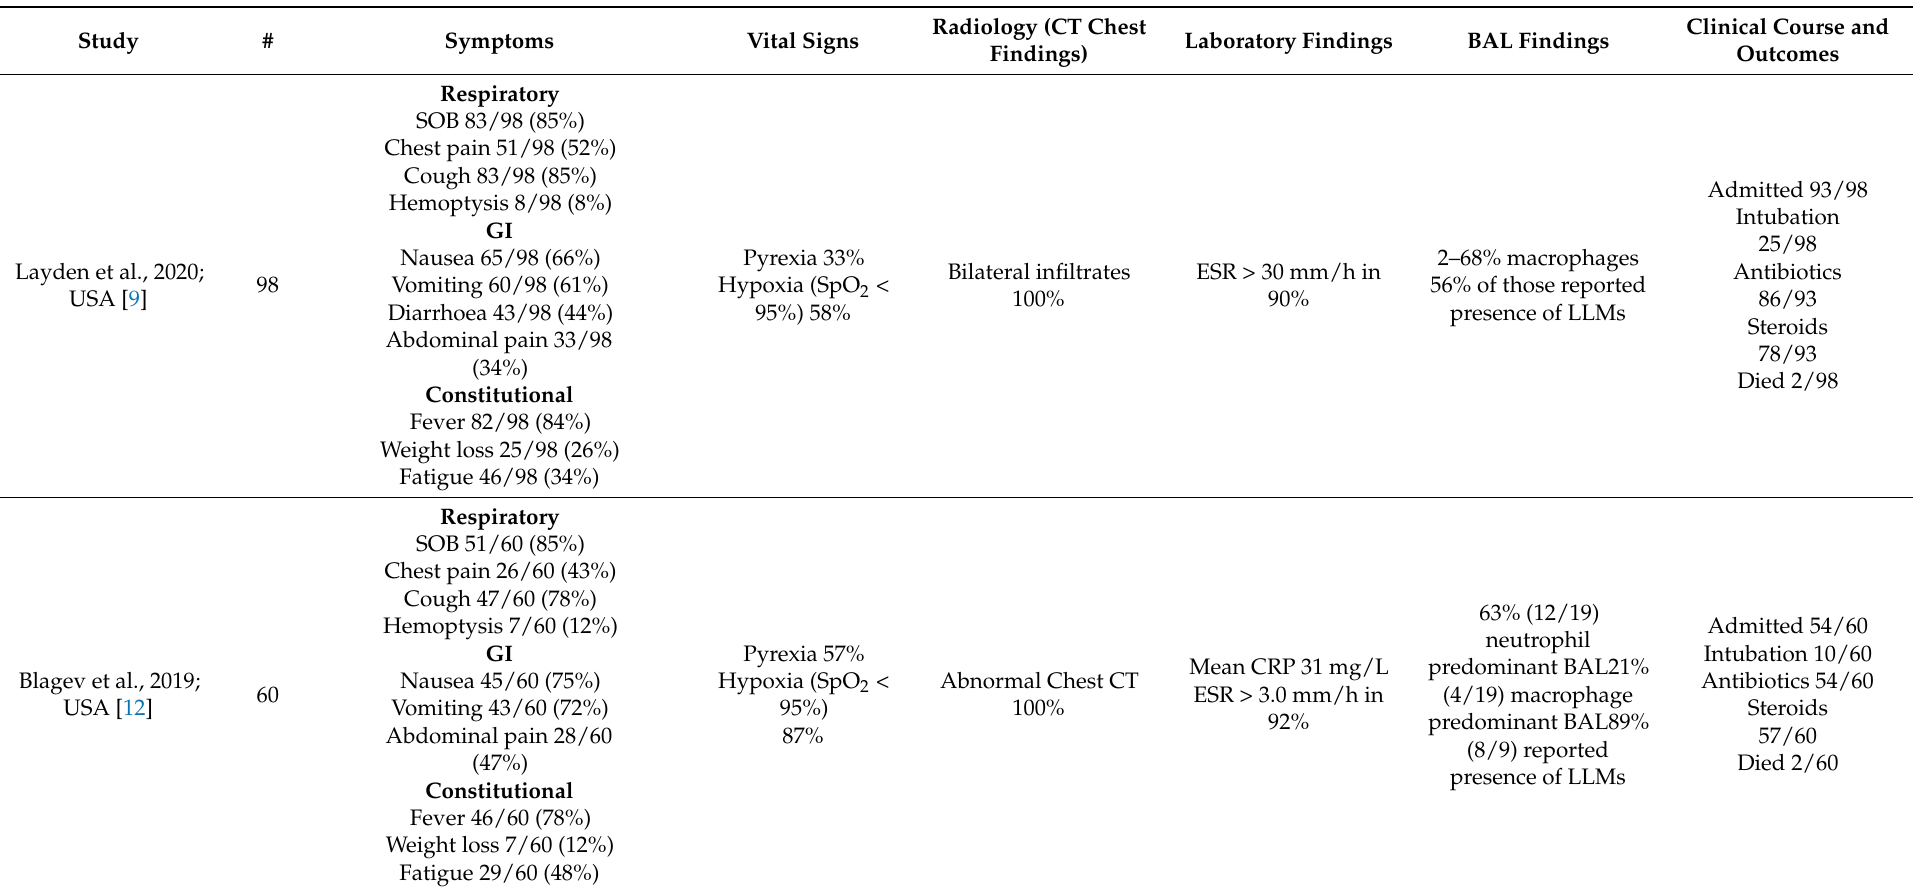
Table 1. Variation in clinical and radiological presentation of patients with